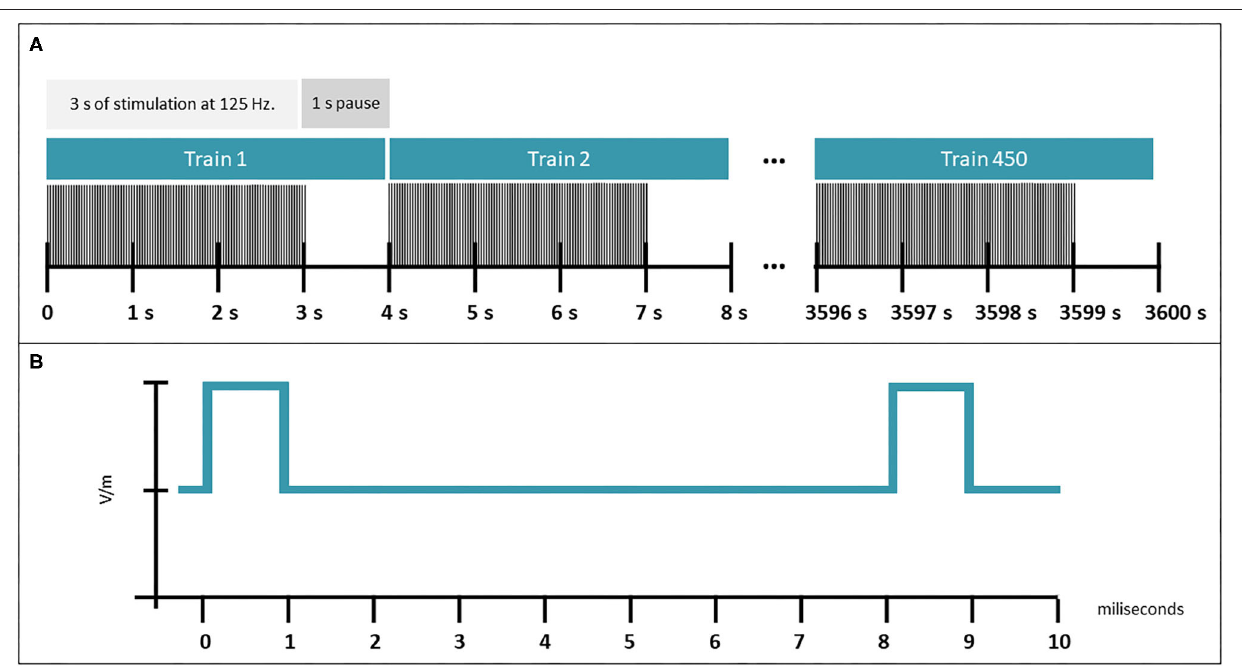
FIGURE 1 | Characteristics of FGMS. (A) Pattern of the magnetic field in trains, consisting of 3-s bursts of pulses at fast gamma frequency (125Hz) alternated with 1-s without stimulation for 450 trains. (B) Pulse pattern delivered.